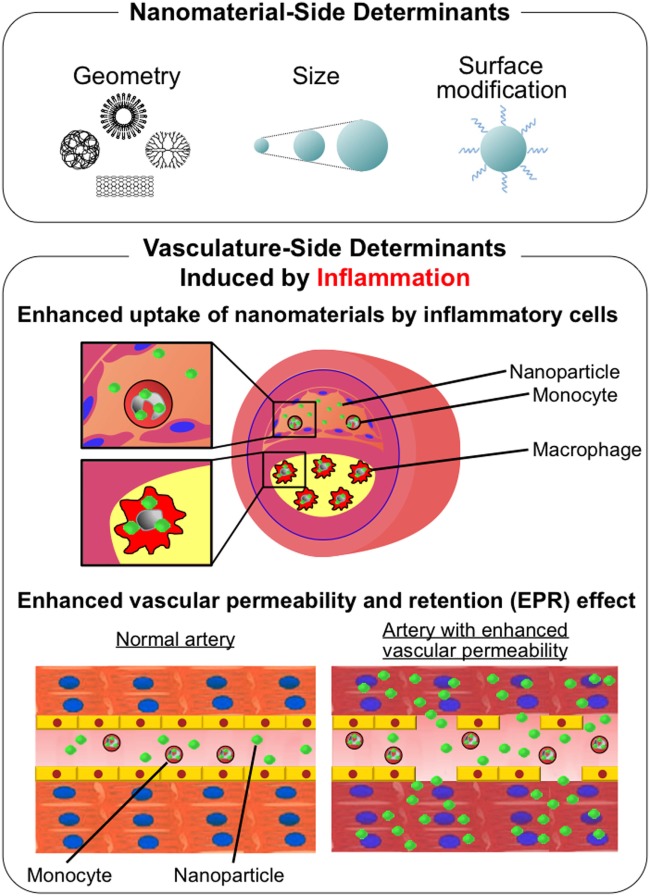
Schematic description of determinants of physiological behavior of nanomaterials. (Upper panel) Nanomaterial-side determinants: geometry, size, and surface modification. (Lower panel) Vasculature-side determinants induced by inflammation: enhanced uptake of nanomaterials by inflammatory cells and enhanced vascular permeability and retention (EPR) effect.